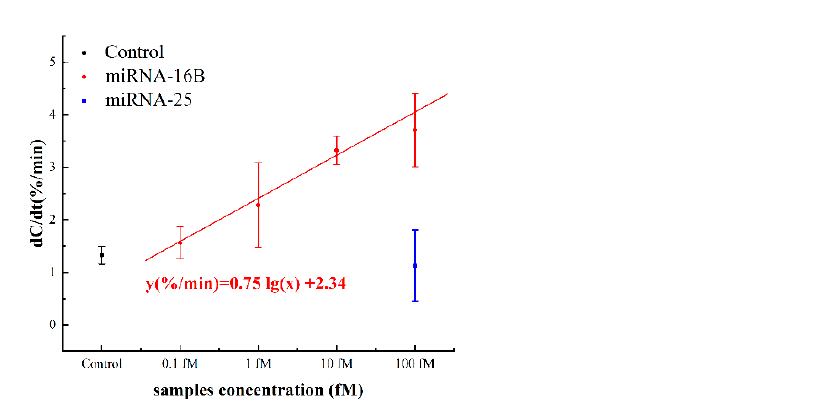
Figure 8. Capacitance change rates in response to different concentrations of spiked miRNA ‐ 16b and miRNA ‐ 25 serum samples.